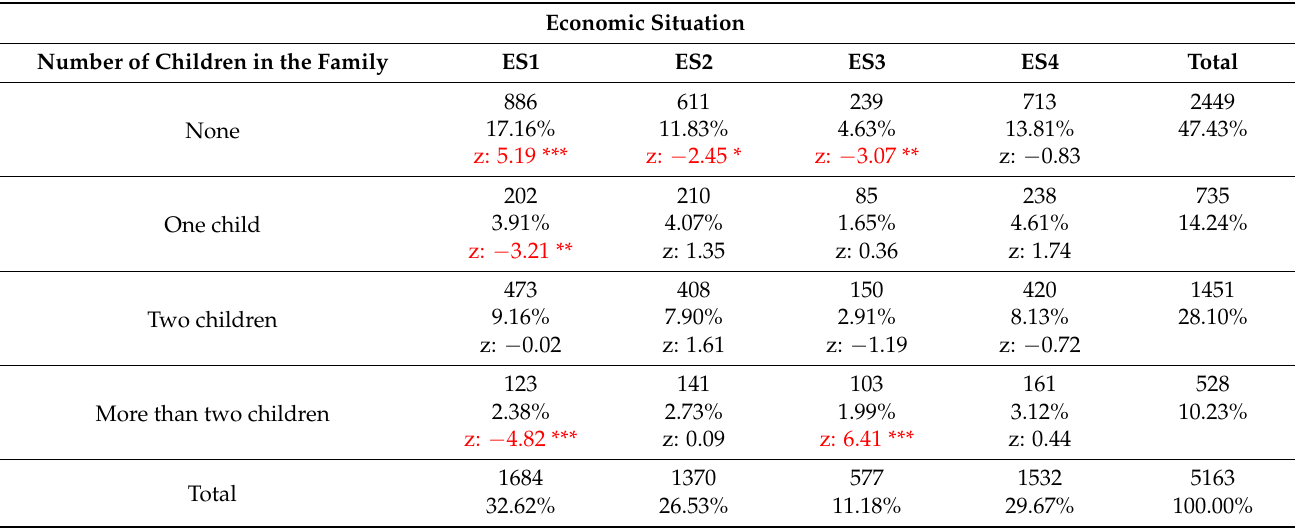
Table 7. Economic situation’s dependence on number of children in the